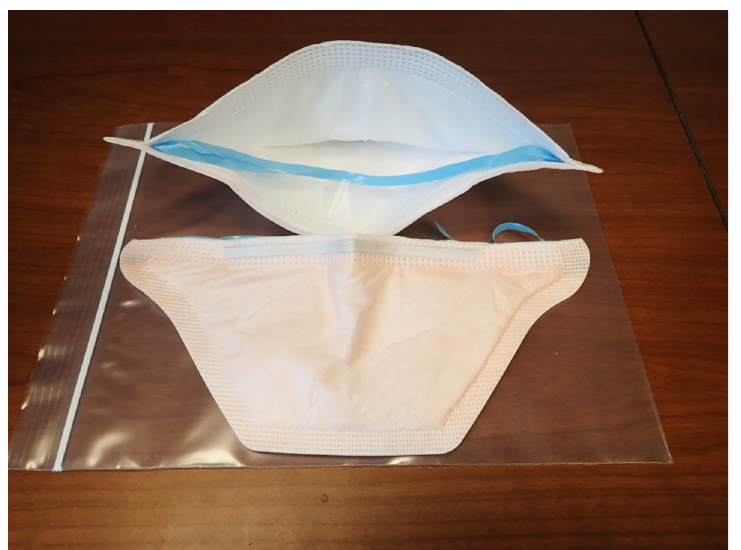
Fig 2. Model 2-N95 pouch/duck-bill respirator.